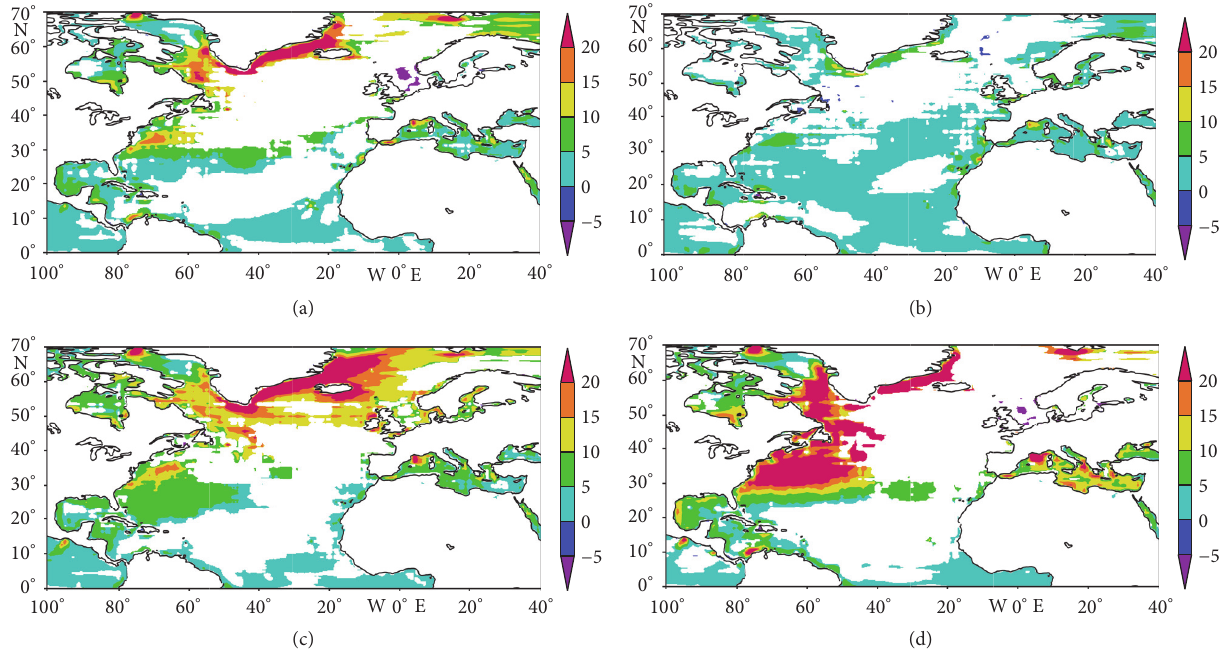
Figure 5: Long-term trends of the wind power density in MAM (a), JJA (b), SON (c), and DJF (d), unit: (W/m 2 )/yr. Only areas significant at the 95% level are